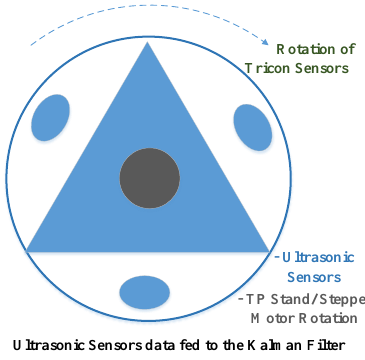
Figure 5. Tricon (three) ultrasonic sensors mounted in circular order.